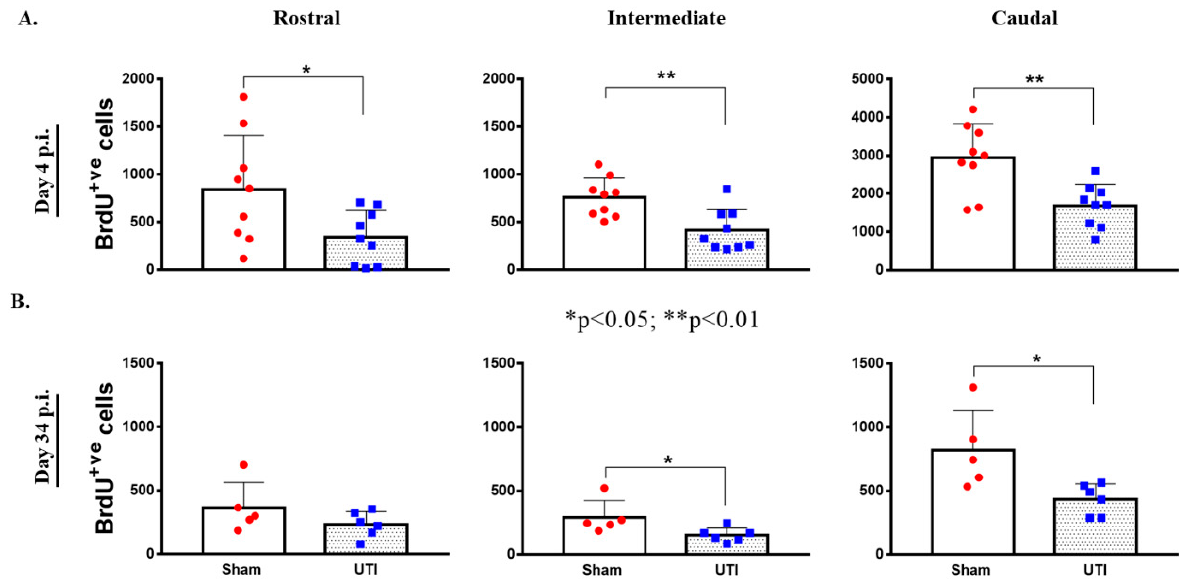
Figure 5. Topographical Distribution of BrdU-positive cells in the DG. Topographical distribution of BrdU-positive cells in the rostral, intermediate, and caudal regions of the DG of rats sacrificed on day 4 ( n = 9 per group) ( A ) or day 34 ( n = 5 for the sham group and n = 6 for rats with a UTI) post infection ( B ). Determination of the significance of differences was generated using an unpaired Student’s t -test.